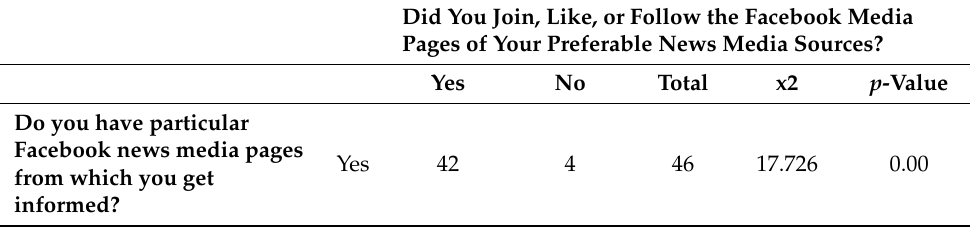
Table 6. A Chi-square test analysis for association between two actions in